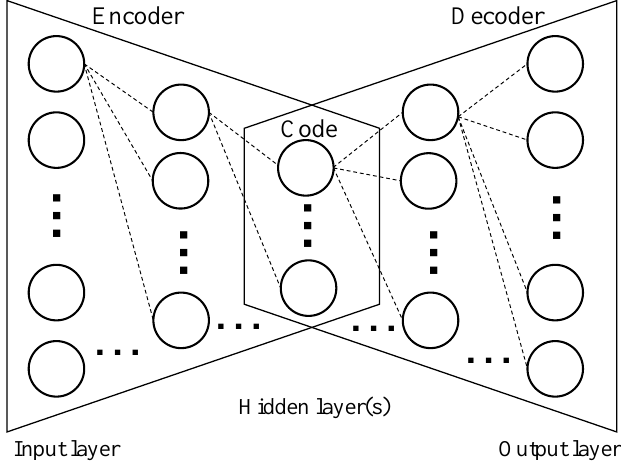
Figure 1. The neural network structure of an autoencoder (AE)